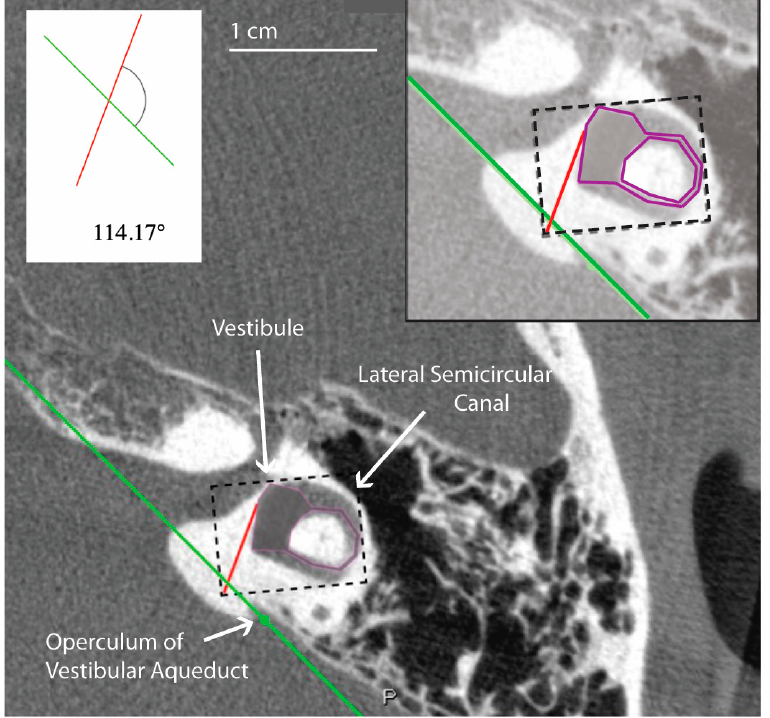
Figure 1. Example of temporal bone reconstruction from flat-panel CT imaging data. Ear (4L) measured using the tool developed by Bächinger et al. [1]. The magenta predefined shape is fitted to the vestibule and horizontal semicircular canal by altering the dimensions of the dashed rectangle. A red line is predefined by Bächinger et al. and fixed to magenta shape [1]. The green line is manually aligned parallel to the trajectory of the distal vestibular aqueduct. The inset shows a magnified view of the components used in the calculation of the angle, which in this case is 114.17 degrees and falls within the normal range.